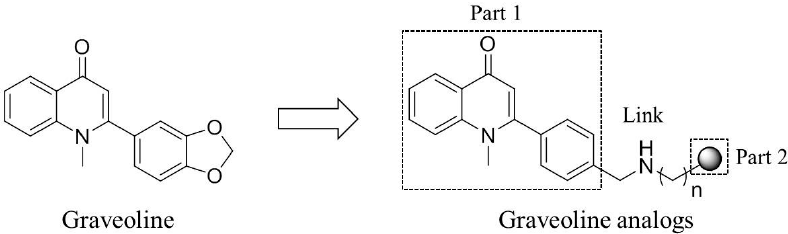
Figure 1. Structure of graveoline and the conventional design idea of dual-target AChE inhibitors.